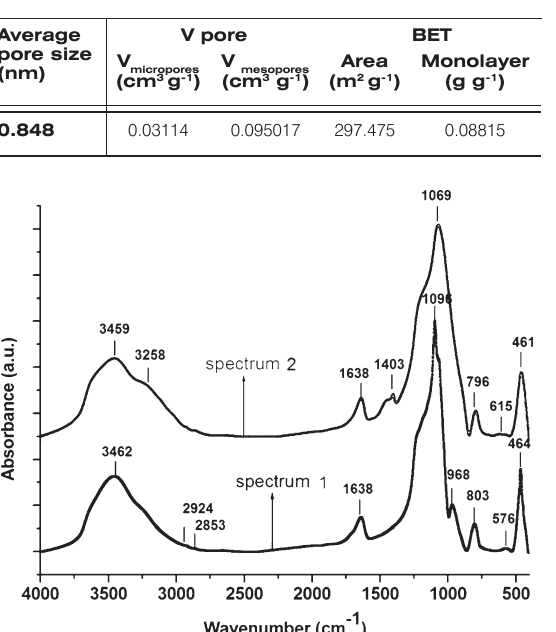
Figure 3. FTIR spectra of the catalyst (spectrum 2) and silica (spectrum 1)